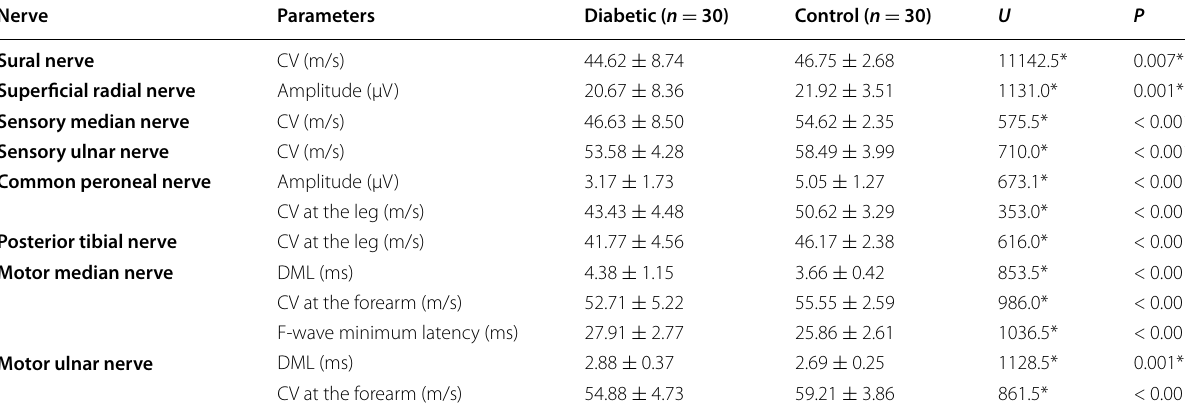
Data are presented as mean SD (minimum-maximum). DML , distal motor latency; U , Mann-Whitney test; CV , conduction velocity. P , P -value for comparing between ± the studied group. *Statistically significant at p 0.05 ≤